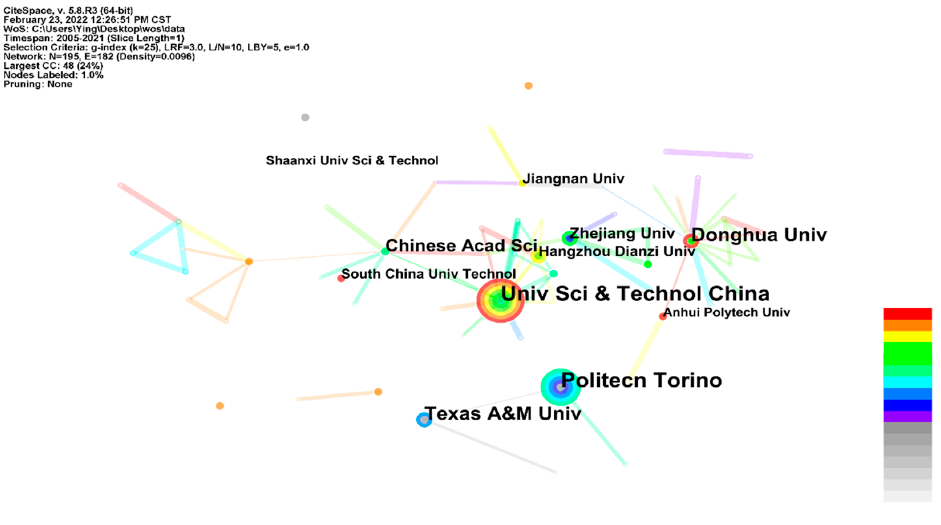
Figure 5. Institute co-authorship network in LbL self-assembly coating on fabric research. Table 3. Top 10 institutes in research on LbL self-assembly coating on fabric ranked by frequency.